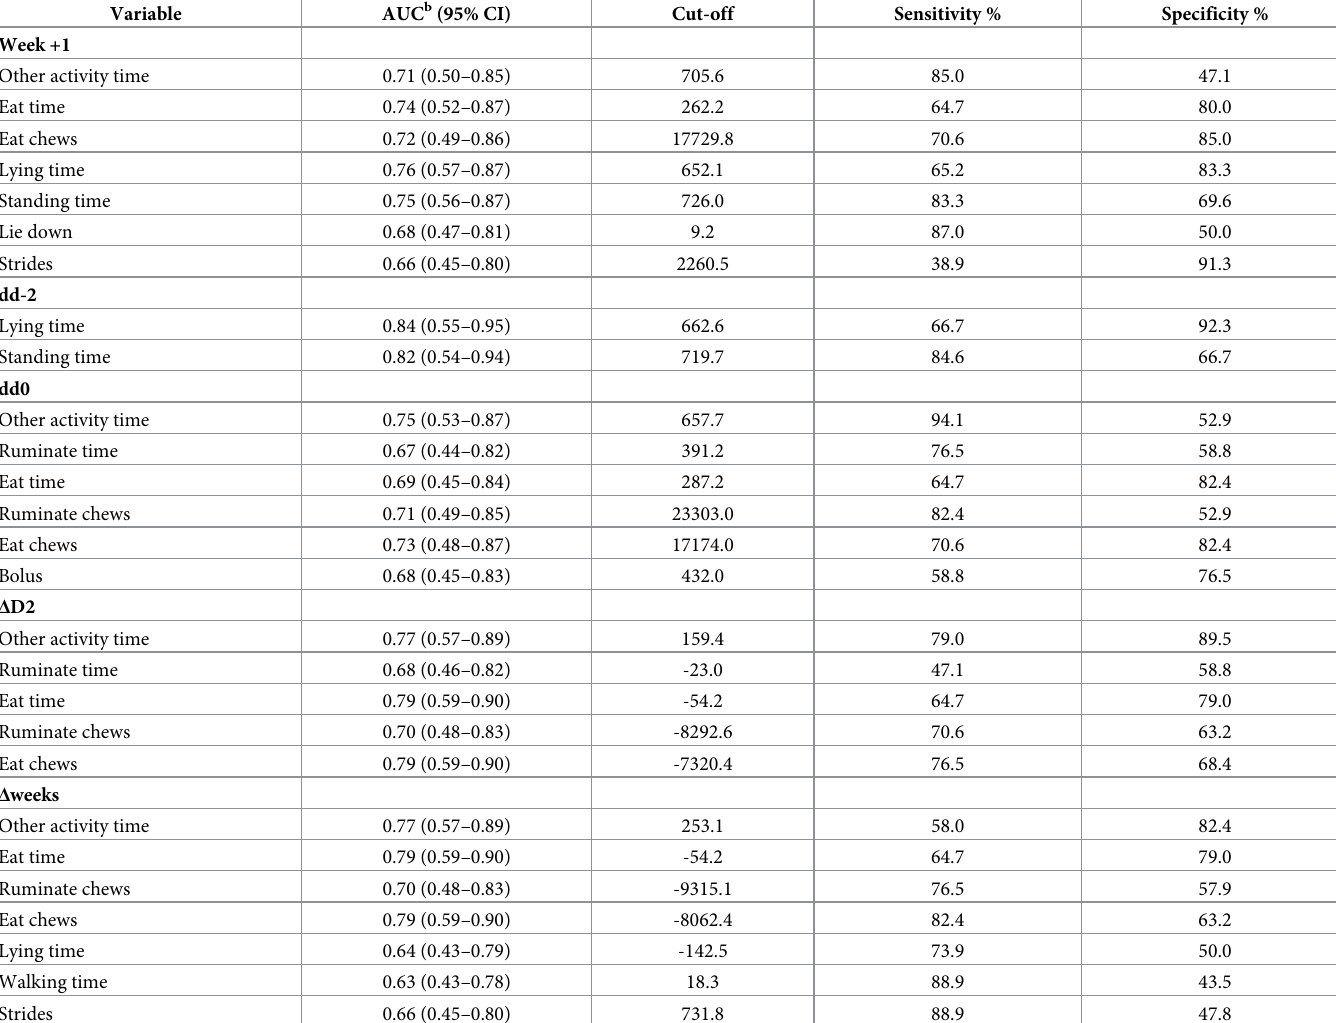
Table 6. Results of the univariable logistic regression models and receiver operating characteristics (ROC) analysis of cows being diseased using different Rumi- Watch 1 halter and pedometer variables and the cut-off values with highest sensitivity and specificity.